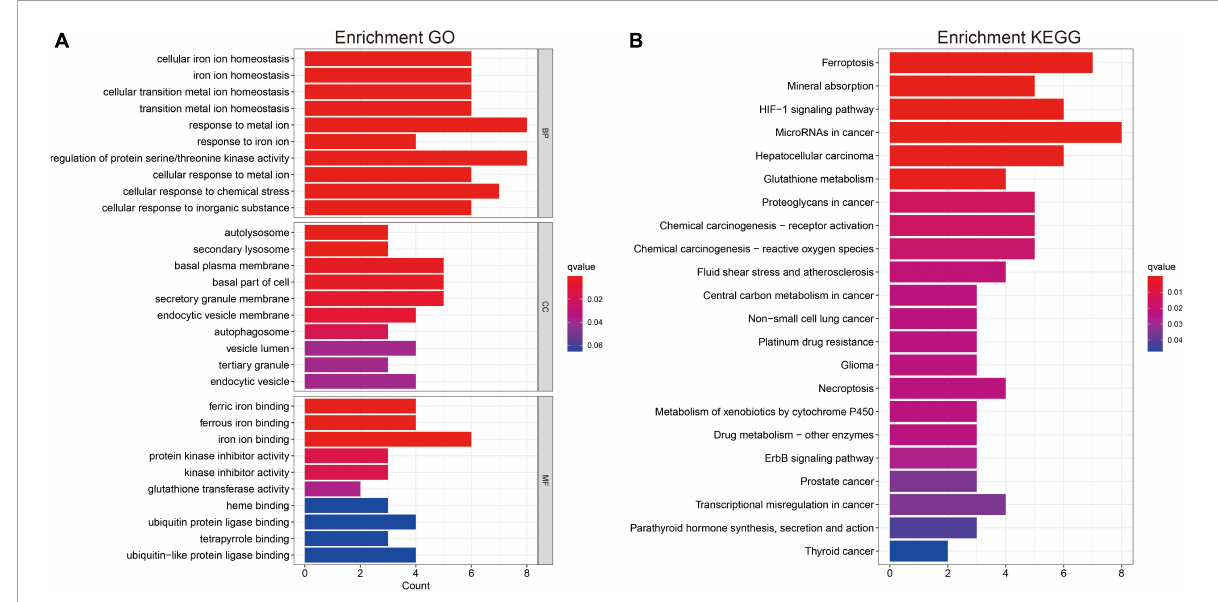
FIGURE9 Gene ontology and KEGG analysis (A,B) . Functional annotation of FRGs using GO terms and the KEGG